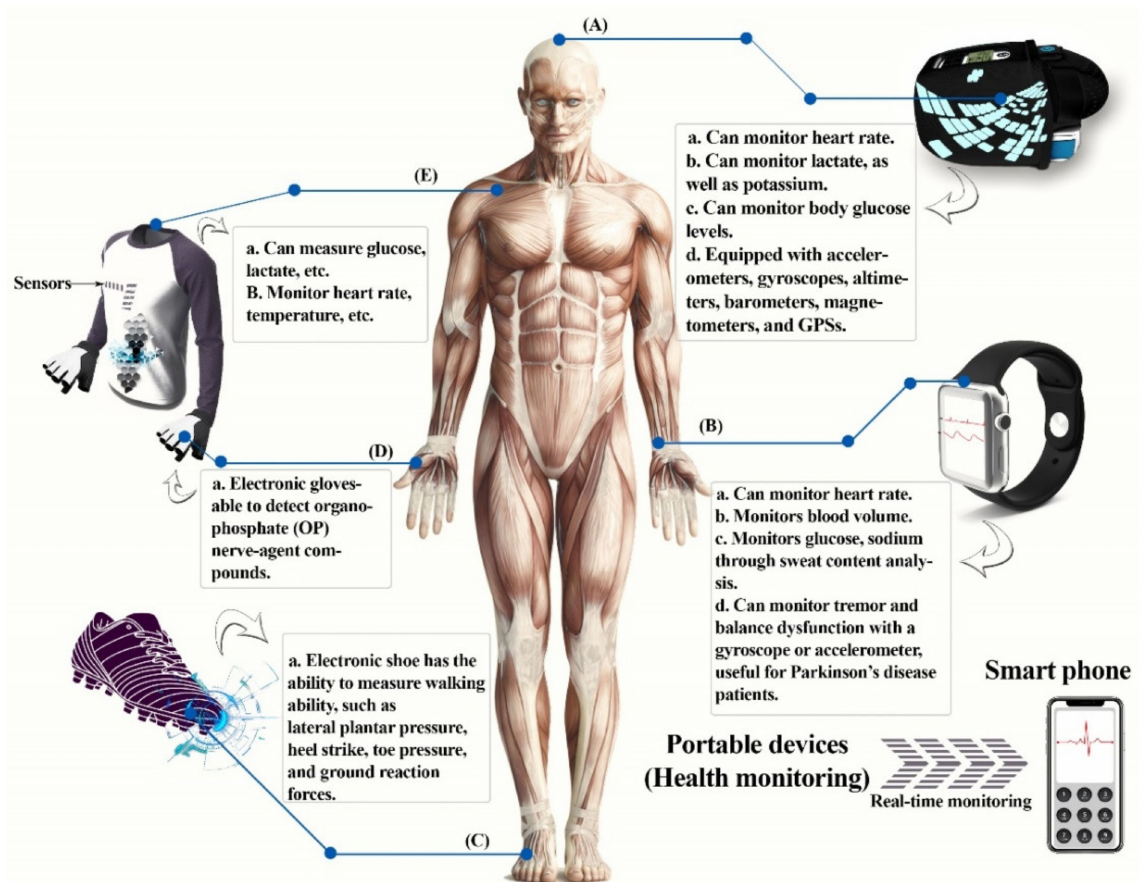
Figure 5. Portable devices for health monitoring. ( A ) Head-mounted devices, ( B ) wrist-mounted devices, ( C ) electronic shoe, ( D ) electronic gloves, ( E ) e-textiles or smart clothing. This diagram was redrawn from